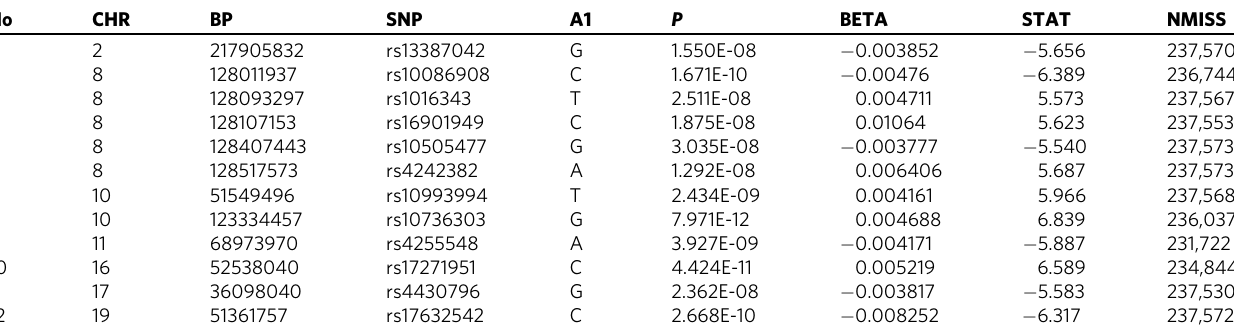
Table 2 Independent loci LD for genome wide signi fi cant SNPs of hormone-sensitive cancers GWAS in the